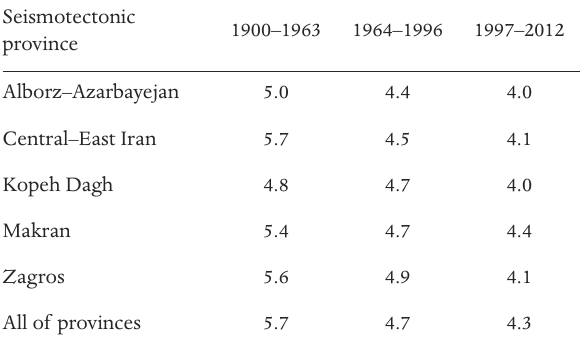
Table 10. Magnitude of completeness (M quakes in each and all major seismotectonic provinces of Iran in three time